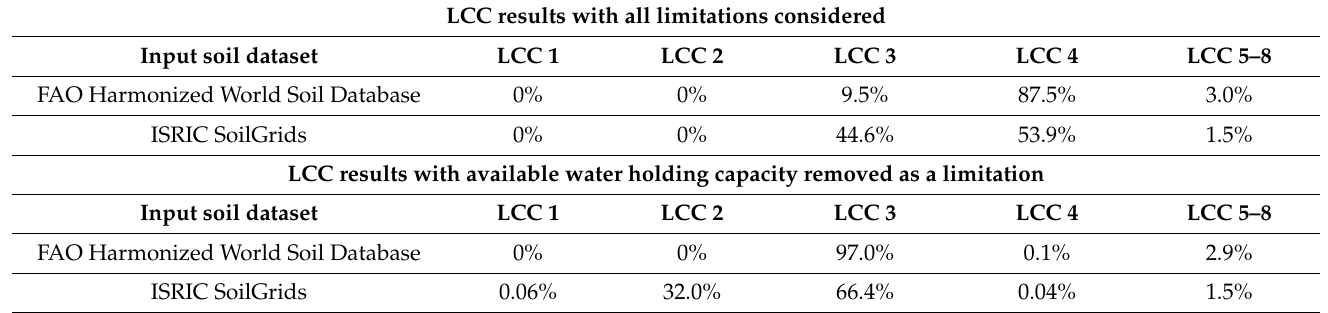
Table 8. Land capability classification breakdown with all limitations considered—digital soil datasets. LCC results with all limitations considered